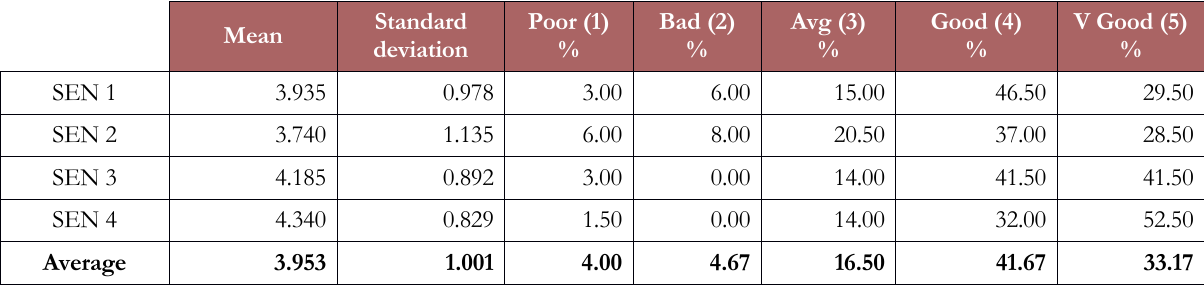
Table 11. Supplier evaluation factor responses